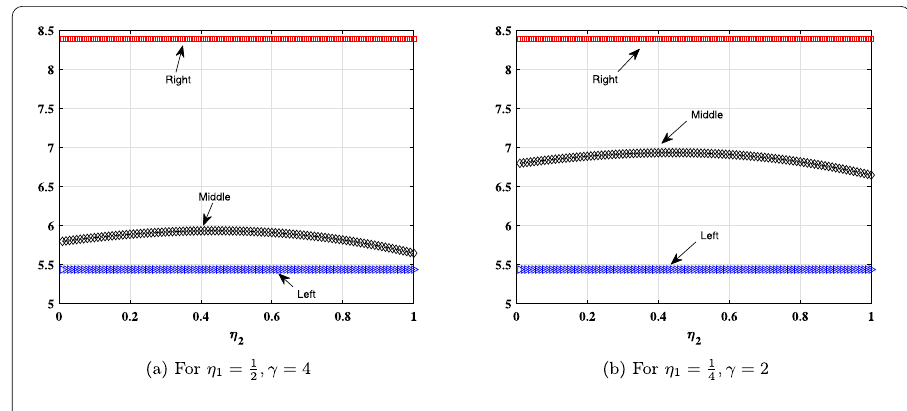
Figure 2 Plot illustrations for Example